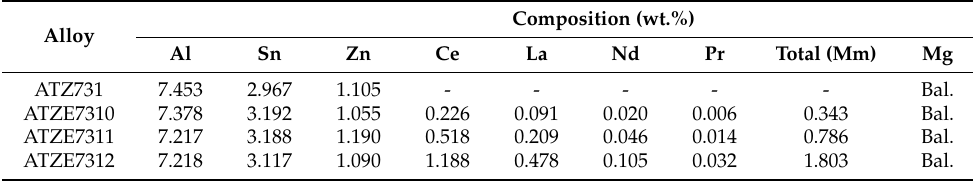
Table 1. Chemical composition of the experiment